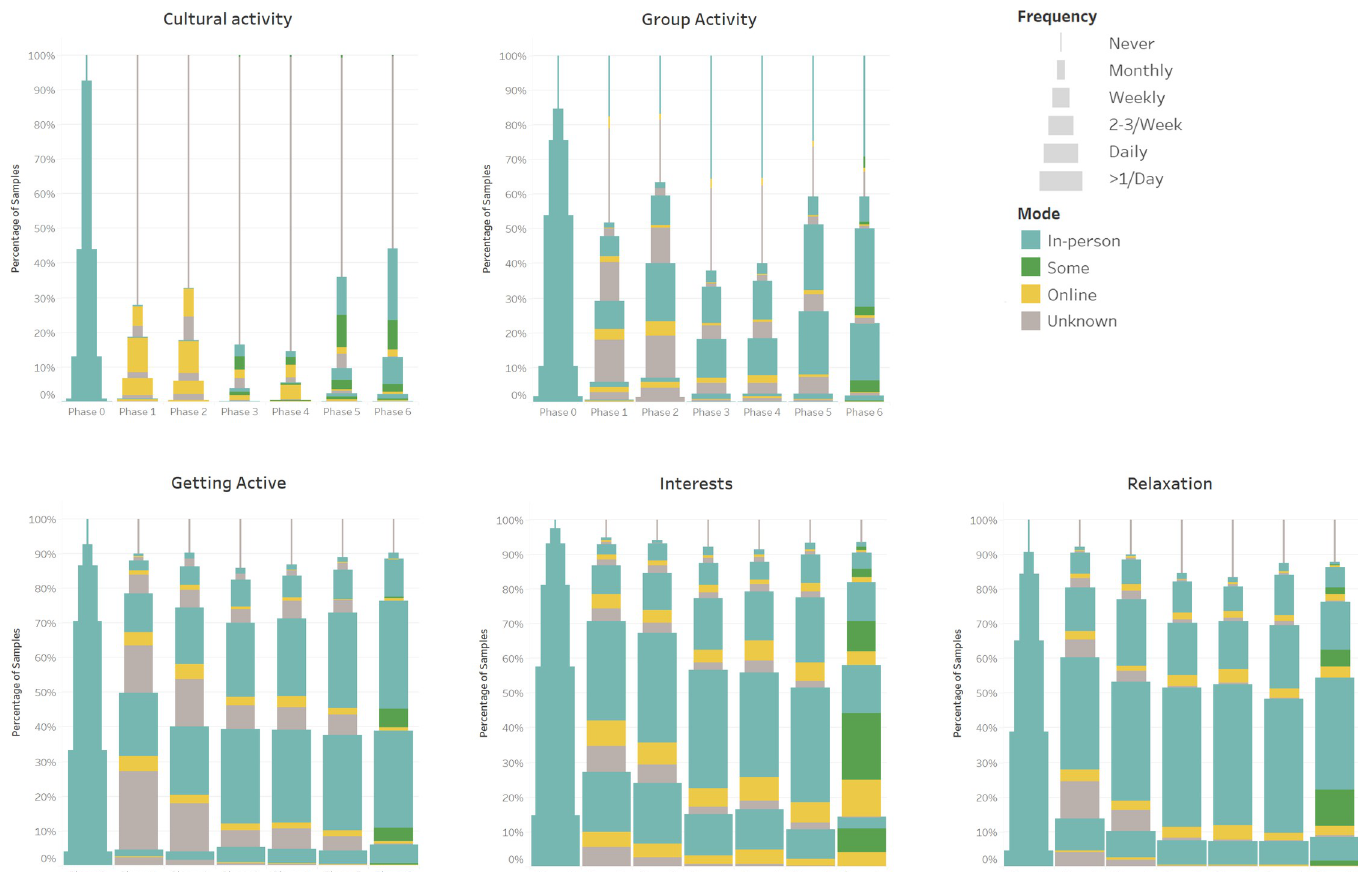
Fig 3. Stacked bar showing the frequency and mode changes of ten activities (6–10) across 7 phases; the modes in phase 0 were assumed to be all doing